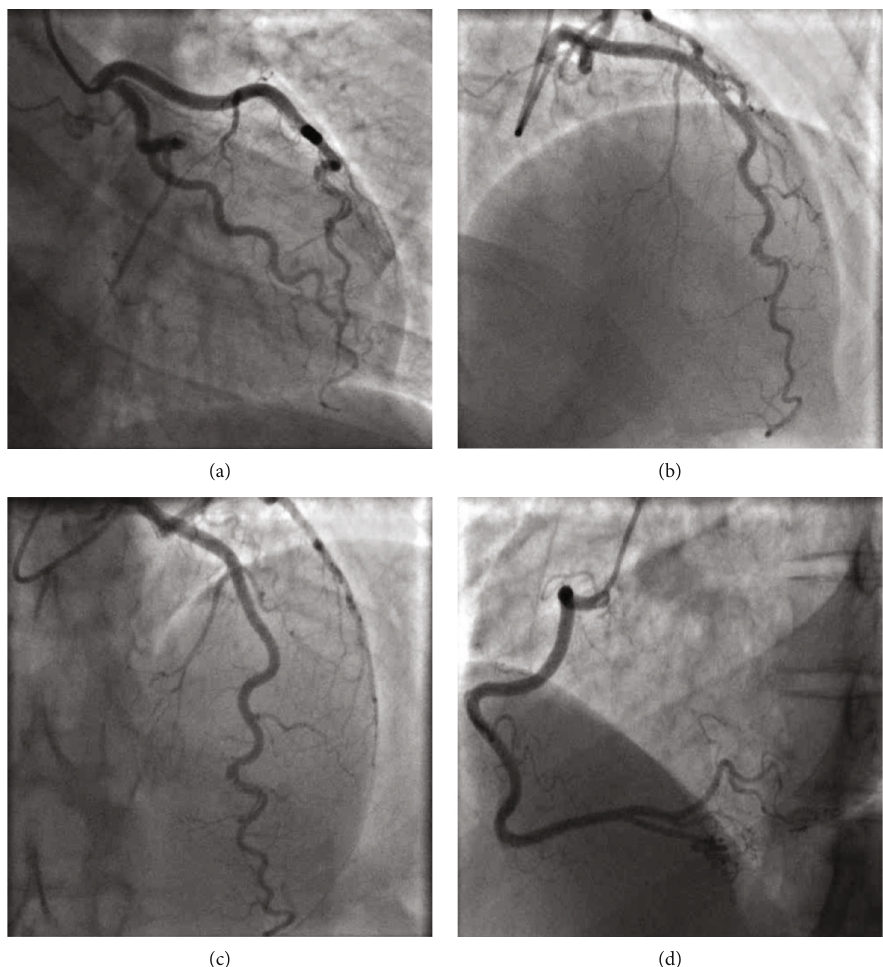
Figure 1: (a – c) Type 1 spontaneous coronary artery dissection (SCAD) (contrast dye staining of the arterial wall with multiple arterial lumens) in the distal LAD. Increased arterial tortuosity ∗ in all three epicardial vessels including RCA (d). ∗ Coronary artery tortuosity is highly prevalent in patients with spontaneous coronary artery dissection and is associated with